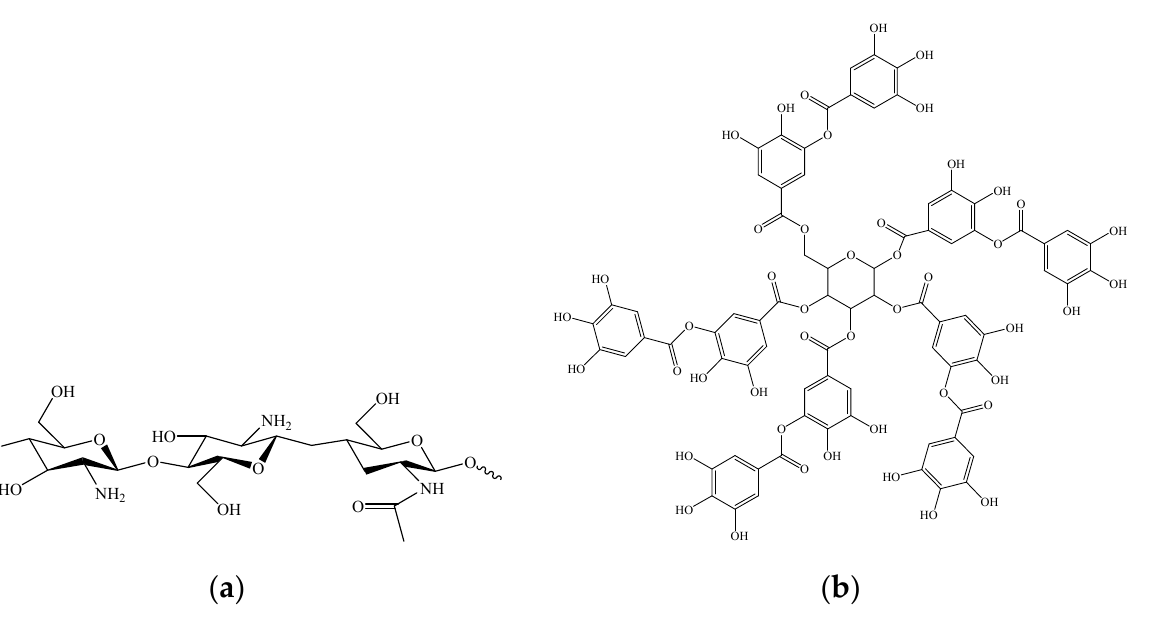
Figure 1. Molecular structures of ( a ) chitosan and ( b ) tannic acid.